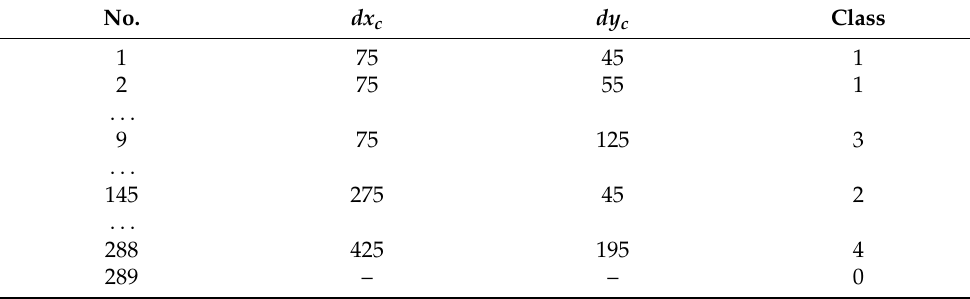
Table 3. The experimental plan for the considered damage scenarios. No. dx c dy c Class 1